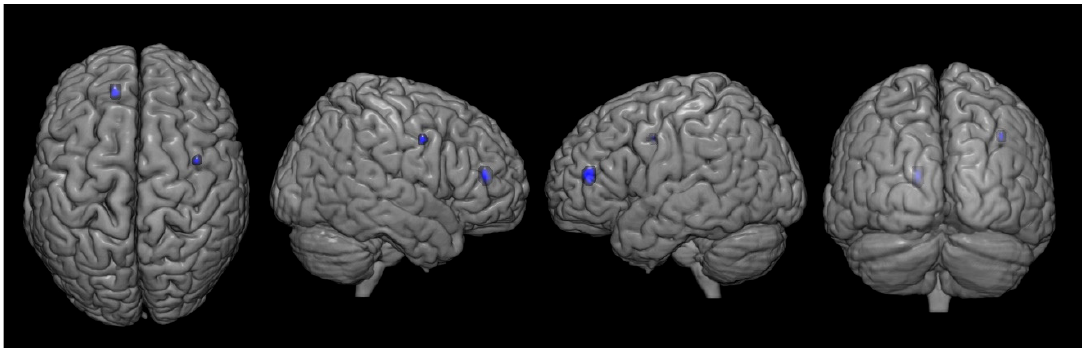
Figure 3. Spatial distributions of decreased glucose metabolism in the central post-stroke pain group following pontine hemorrhage compared with that in the control group. ( P uncorrected < 0.001, k = 10). Table 2. Location and size of hemorrhage and corresponding pain location and characteristics for each patient with central post-stroke pain.